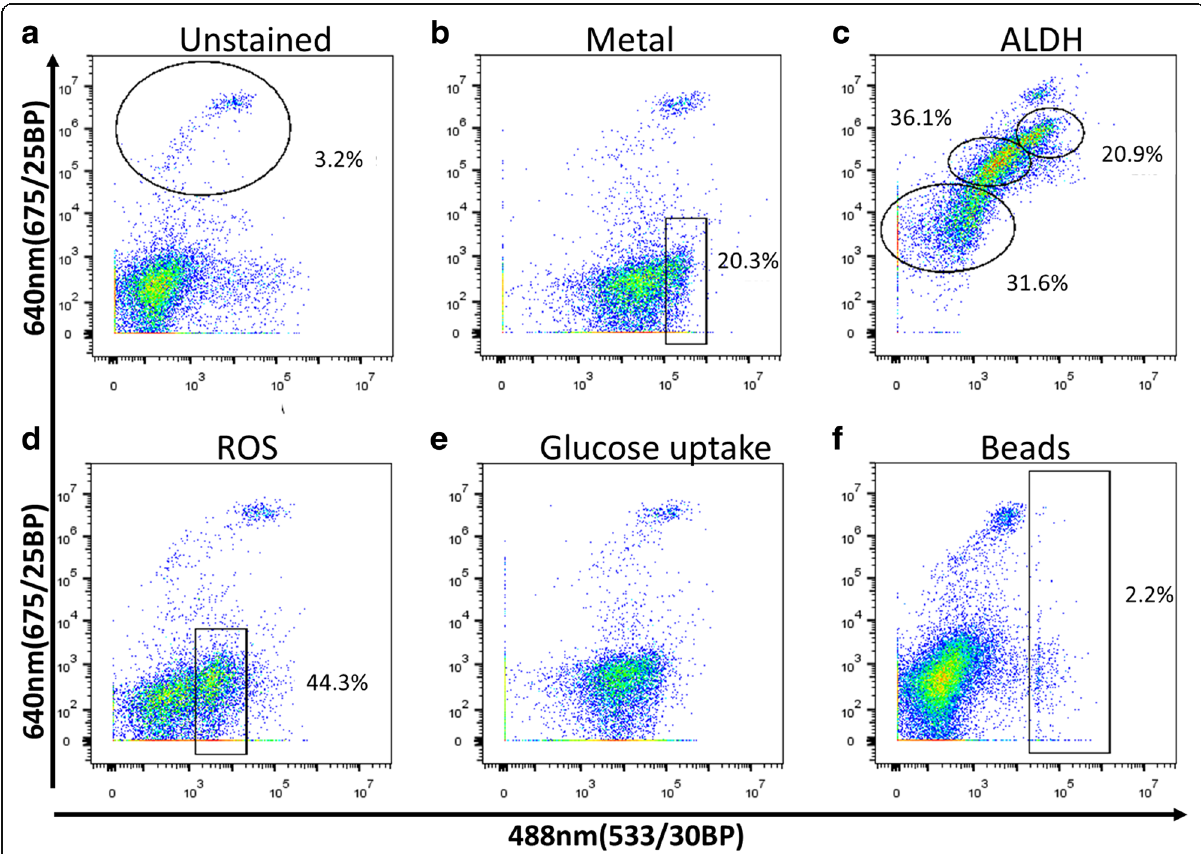
Fig. 2 Coral cell differentiation patterns. P. damicornis cell suspension was incubated with different fluorescent markers and analyzed on FACS Accuri C6. All of the samples were analyzed on two dimensional plots of the green channel- 488 nm (533/30BP) and on the far-red channel- 640 nm (675/25BP) to differentiate the Symbiodinium positive cells. Gated in black are the differentiated populations with their cell percentage indicated. The analysis was done after differentiation of cells and debris on FSC and SSC and live/dead cells using PI. a ) Background control of unstained cells for all of the panels. In the gate are the Symbiodinium cells positive at 640 nm (675/25BP) due to natural fluorescence. b ) Labeled cells with Phen Green, a color that is quenched by bi-valent metals. A small population of cells had the lowest level of metal and it differentiated from the main population. c ) Labeled cells with ALDEFLUOR that indicates high levels of ALDH activity. No clear differentiation was found, but the width of the signal in different cells is 3 fluorescent log scales which enables us to differentiate low, moderate and high labeling. d ) Cells containing ROS, labeled with CellRox. Clear negative and positive populations (positive marked) were identified. Note that all the Symbiodinium positive cells are positive to ROS. e ) Cells were incubated with glucose analog 2-NBDG. Positive labeling was found, but no clear differentiation. f ) Cells were co-incubated for 3 h with green fluorescent beads for analysis of engulfment. Cells positive to beads are